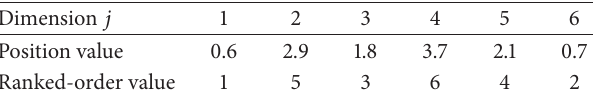
Table 1: The example of ROV